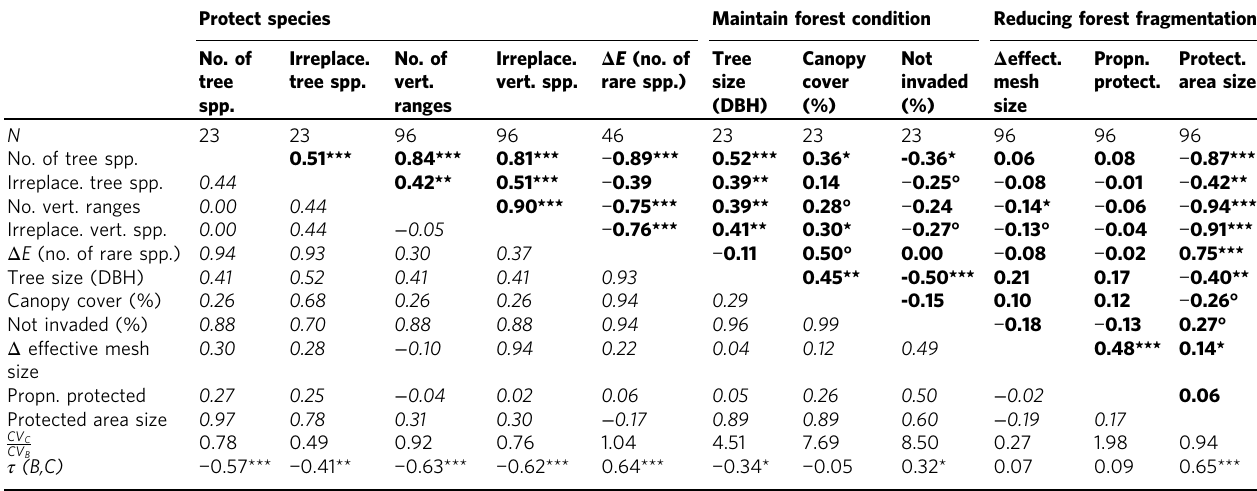
Propn. Protect. protect. area size 96